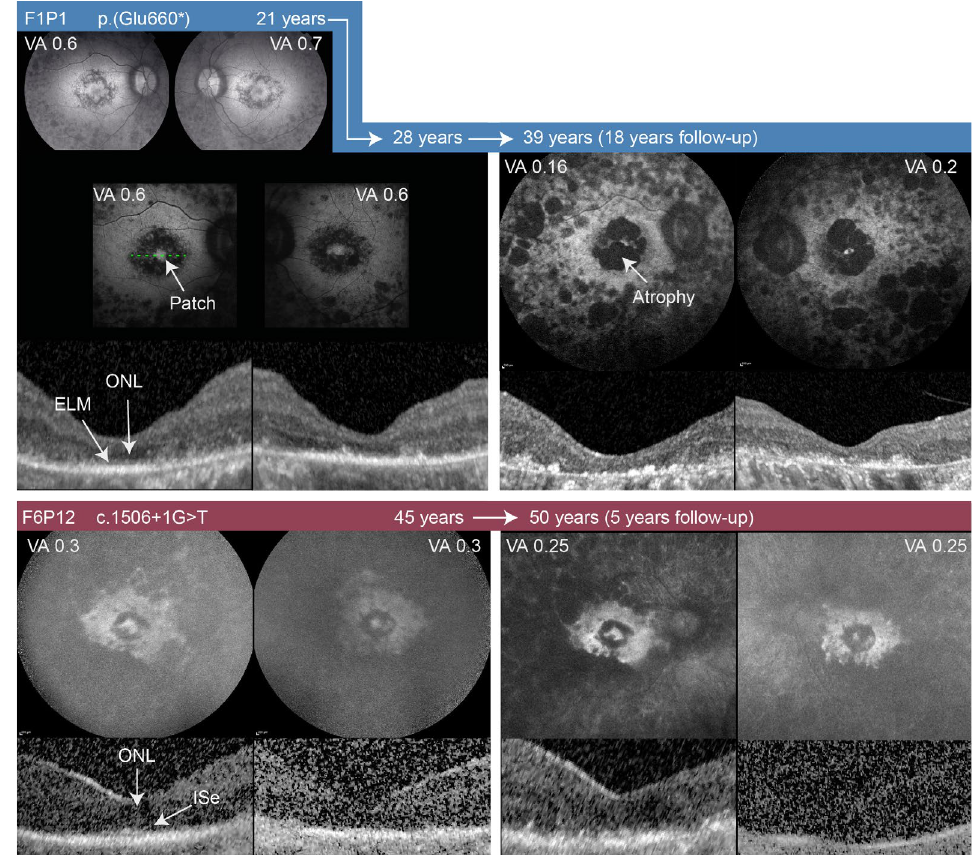
Figure 2. FAF and central OCT (green dashed line) of male RP patients from families 1 and 6. Follow -